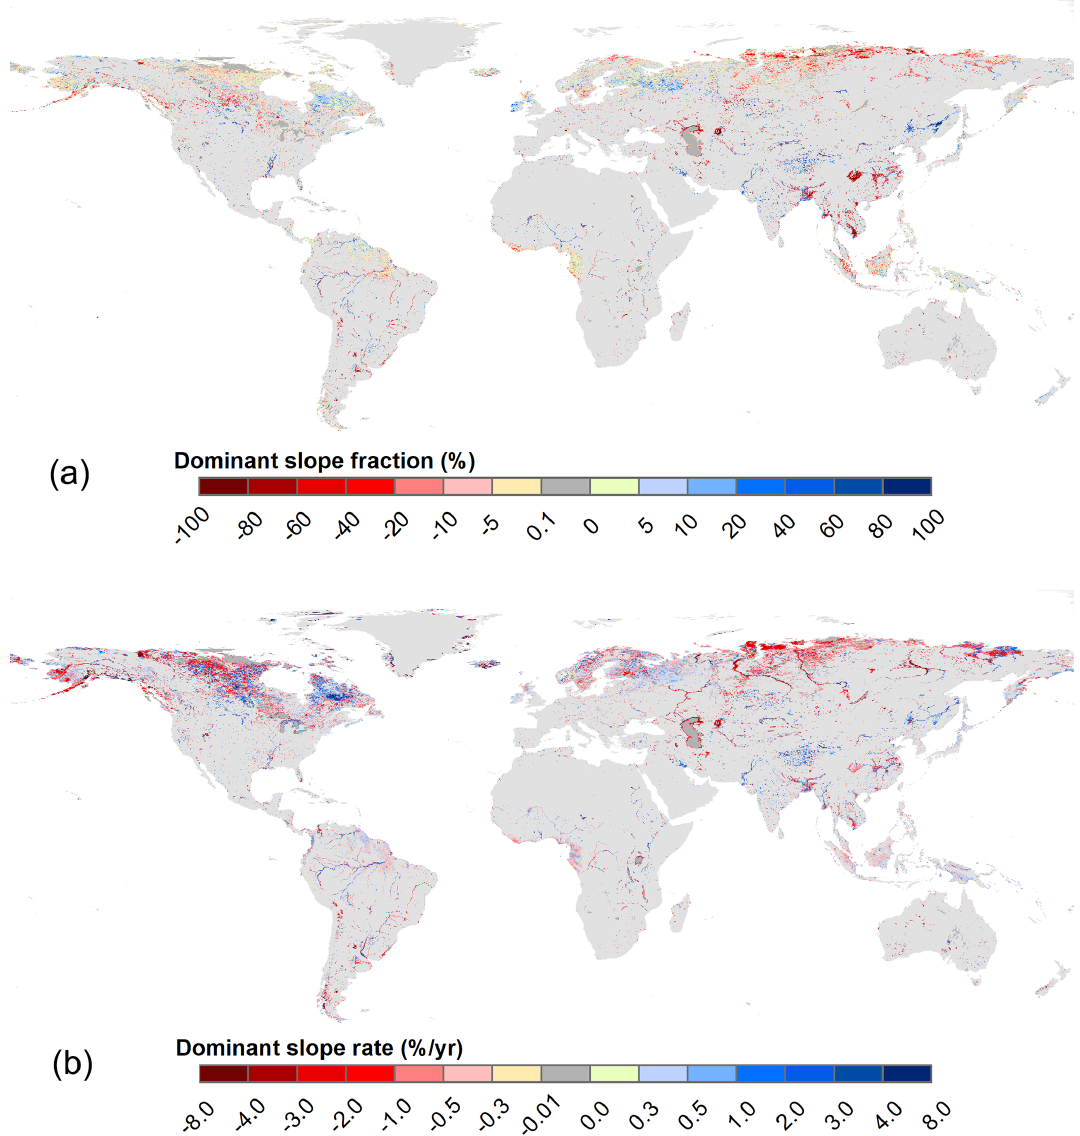
Figure 8. Linear trend of surface water cover frequency during 2001 and 2020. The trend maps were aggregated to 10km resolution for visu- alization. (a) Dominant SWF slope fraction (%). The positive (negative) fraction means that the fraction of pixels has increasing (decreasing) SWF ( p < 0 . 05) in each 10km grid, indicating whether the inundation frequency is dominantly increasing (decreasing). (b) Dominant SWF change rate (%yr − 1 ). The positive (negative) slope rate means that the mean linear slope rate of pixels has increasing (decreasing) SWF ( p < 0 . 05) in each 10km grid, whichever is faster, indicating whether the inundation frequency is increasing (decreasing) rapidly. The light grey refers to non-water-covered